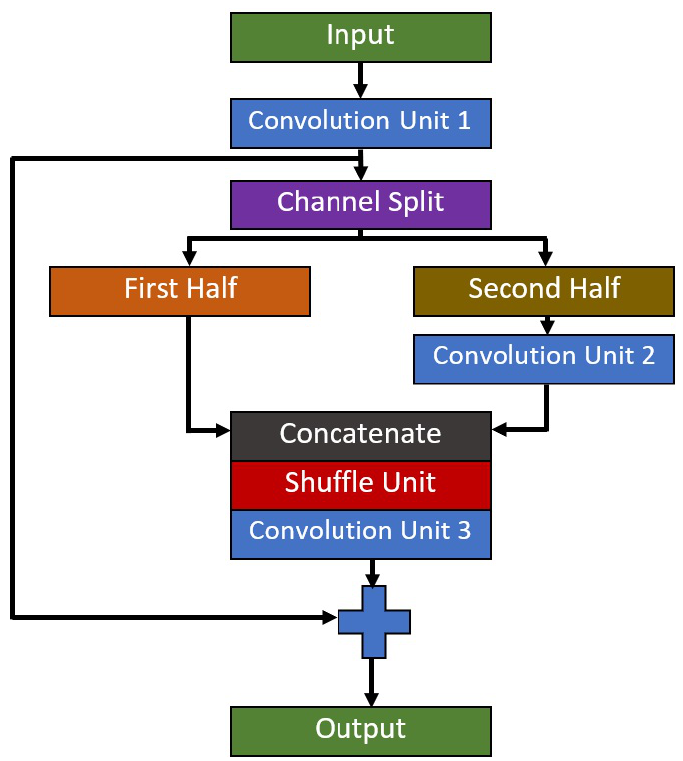
Figure 2. Architecture of the Residual-Shuffle